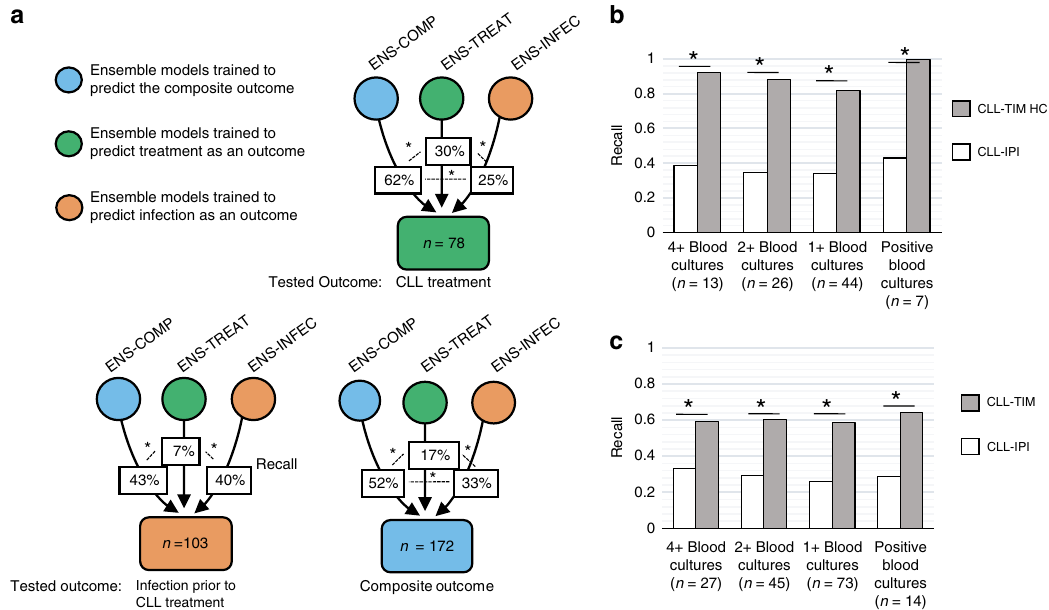
Fig. 6 Linking immune dysfunction and CLL treatment. a Modeling infection and CLL treatment separately and jointly. Results shown for patients with full 2-year follow-up on internal test cohort ( n = 530). Percentages indicate the average recall resulting from 29 ensembles (2 – 30 base-learners) generated in each of the three protocols. The protocols differ in the target outcome they were trained to predict: ENS-INFEC (orange circle) predict infection as a fi rst event; ENS-TREAT (green circle) predict treatment; ENS COMP (blue circle) predict the composite outcome. Irrespective of the outcome they were trained on, all protocols were tested for their ability to predict three different outcomes: Infection prior to CLL Treatment (with n = 103 patients having this outcome), CLL treatment ( n = 78), composite outcome, which includes infection and/or CLL treatment ( n = 172). The average recall for each set of ensembles represents the extent to which, patient data necessary for modeling one outcome (trained outcome) is predictive of another outcome (tested outcome). b Recall for alternative infection outcomes for CLL-TIM ’ s high con fi dence predictions on BENCH-I ( N = 145). In this work we use the drawing of a blood culture (1 + blood cultures), irrespective of the result, as a proxy for clinical infection. 4 + and 2 + are patients who had at least four and at least two blood cultures drawn within the fi rst 2-years post CLL diagnosis, respectively. c Recall for alternative infection outcomes for all of CLL-TIM ’ s predictions on BENCH-I ( N = 288). For CLL-IPI score we used CLL-IPI 4 + where score of 4 and above is considered as a high-risk prediction and below 4 as low-risk. Only 10% of blood cultures taken in the Danish CLL population had a positive fi nding. Precision was not calculated for each of these four outcomes, as the false- positive predictions (according to each outcome) may still refer to patients who had CLL treatment. For CLL-TIM HC, CLL-TIM and CLL-IPI, precisions for the composite outcome were 0.72, 0.63, and 0.60, respectively. * indicates p < 0.05 for one-tailed binomial test for difference in